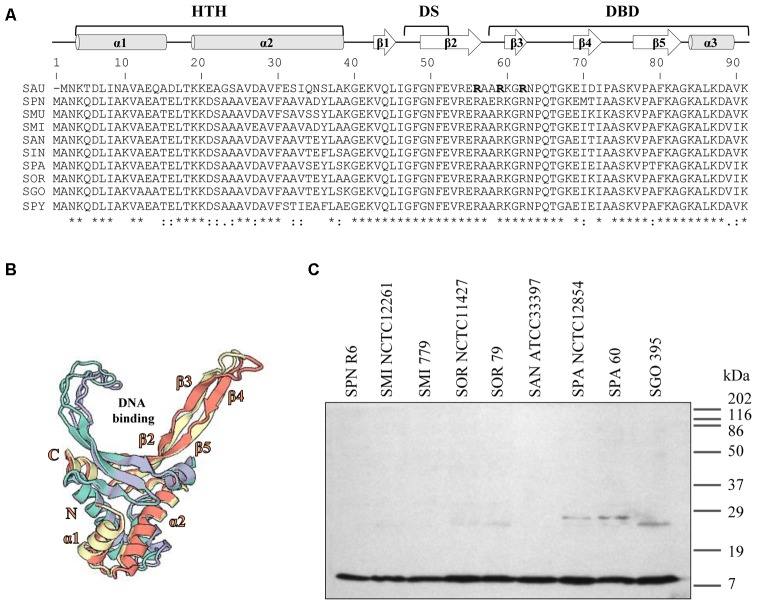
Streptococcal HU homologs are highly conserved. (A) Multiple sequence alignment of streptococcal HU homologs and Staphylococcus aureus (SAU) HU protein (SauHU). Above the alignment, secondary structural elements are shown. The secondary structure was predicted based on the position specific-scoring matrices generated by PSI-BLAST with the Pyre2 portal for protein modeling, prediction, and analysis (Kelley et al., 2015). HTH, helix-turn-helix; DS, dimerization signal; and DBD, DNA-binding domain. Residues that are crucial for DNA recognition and binding are denoted in bold face and shadowed. Below the alignment, conserved residues are identified by asterisks. SPN (Streptococcus pneumoniae), SMU (Streptococcus mutans), SMI (Streptococcus mitis), SAN (Streptococcus anginosus), SIN (Streptococcus intermedius), SOR (Streptococcus oralis), SGO (Streptococcus gordoni), SPA (Streptococcus parasanguinis), and SPY (Streptococcus pyogenes). (B) The 3D model of the SpnHU homodimer based on the crystal structures of SauHU (4qjn, homodimer subunits in green and purple) and SMU (5fbm, homodimer subunits in yellow and pink). This structure has been modeled with coverages of 98% (SAU) and 100% (SMU) of the SpnHU sequence using Swiss-Model (Biasini et al., 2014). (C) Western blot analysis of HU protein in different streptococcal species. Crude cell extracts (20 μg) were separated by SDS-PAGE, blotted, and incubated with an antibody directed against SpnHU protein.